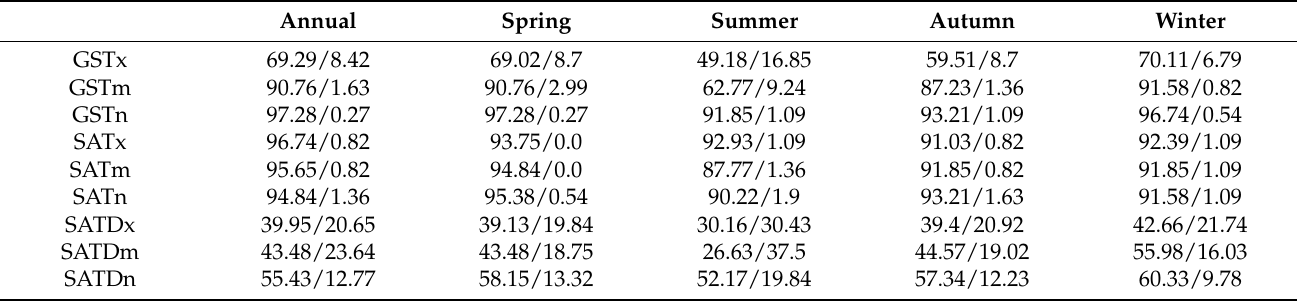
Table 5. Percentage of significant ( p ≤ 0.05) increasing/decreasing stations of annual and seasonal averaged GST-, SAT-, and SATD-related indexes in Southwest China from 1980 to